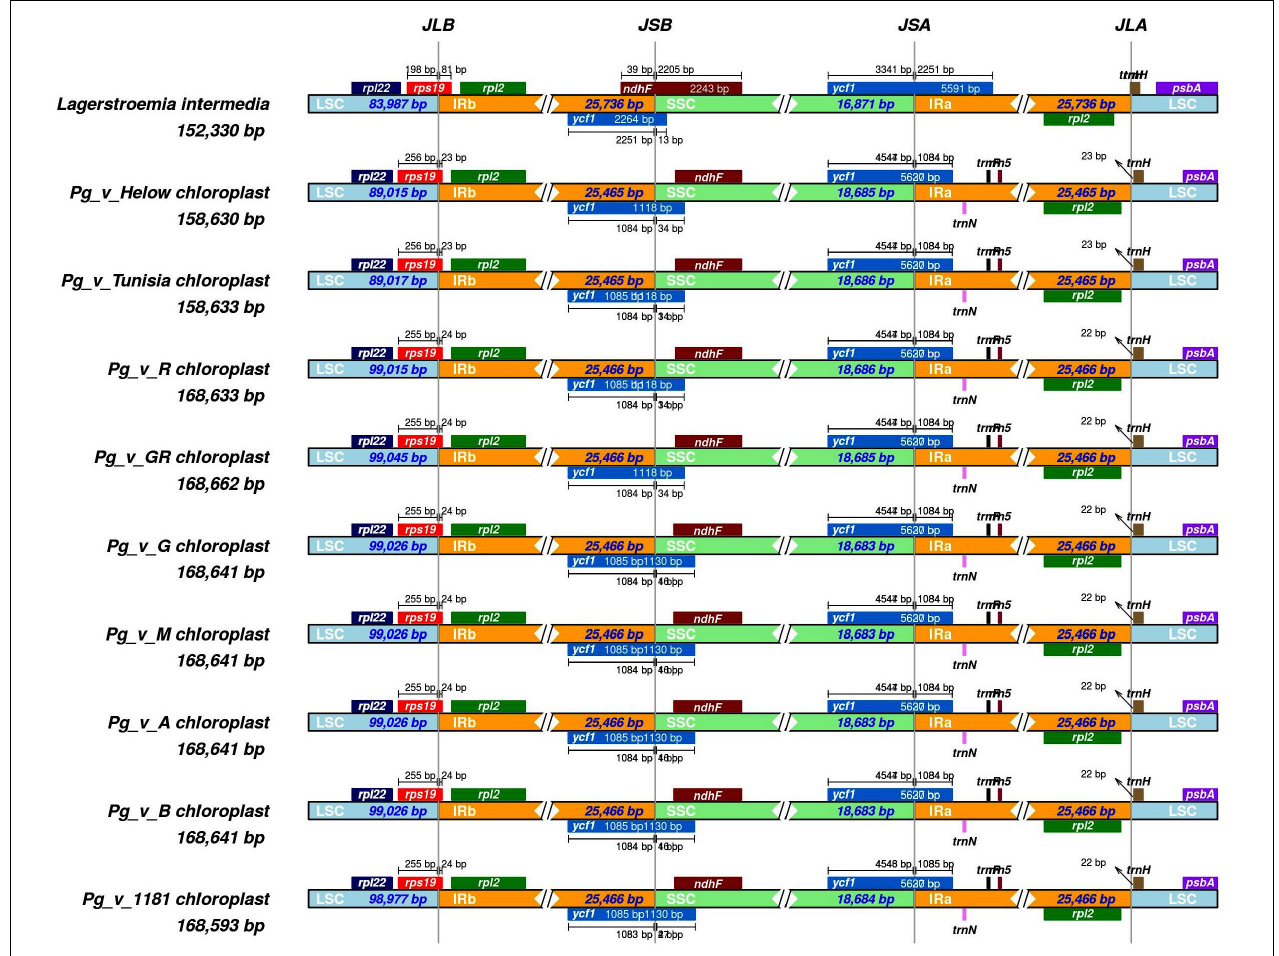
FIGURE 3 | Comparison of the borders of the large single copy (LSC), small single copy (SSC), and IRs regions among representative pomegranate and Lagerstroemia cp